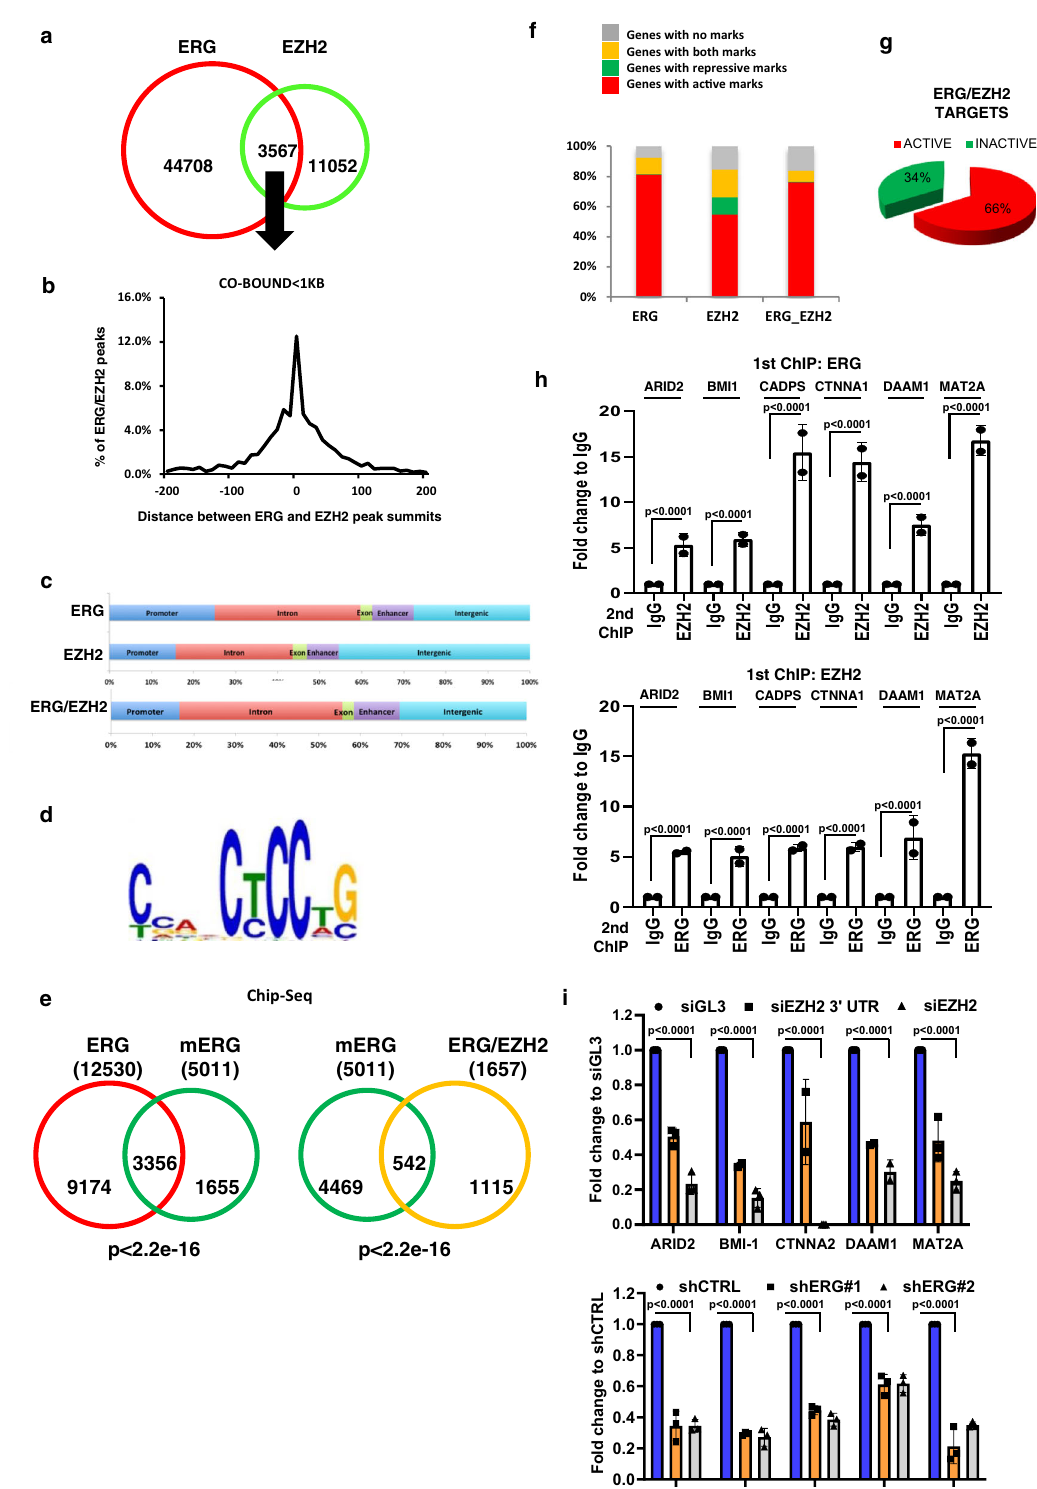
ERG/EZH2 activation is associated with PTEN deletion and tumor progression in transgenic/knockout mice . To gain evi- dence of the link between ERG methylation and prostate cancer progression, we took advantage of the Pb-Cre4;Rosa26 ERG/ERG (ERG mice) with prostate-speci fi c expression of ERG and of the combined Pb-Cre4;Pten fl ox/ fl ox ;Rosa26 ERG/ERG (ERG/PTEN mice) with prostate-speci fi c ERG expression and PTEN deletion.